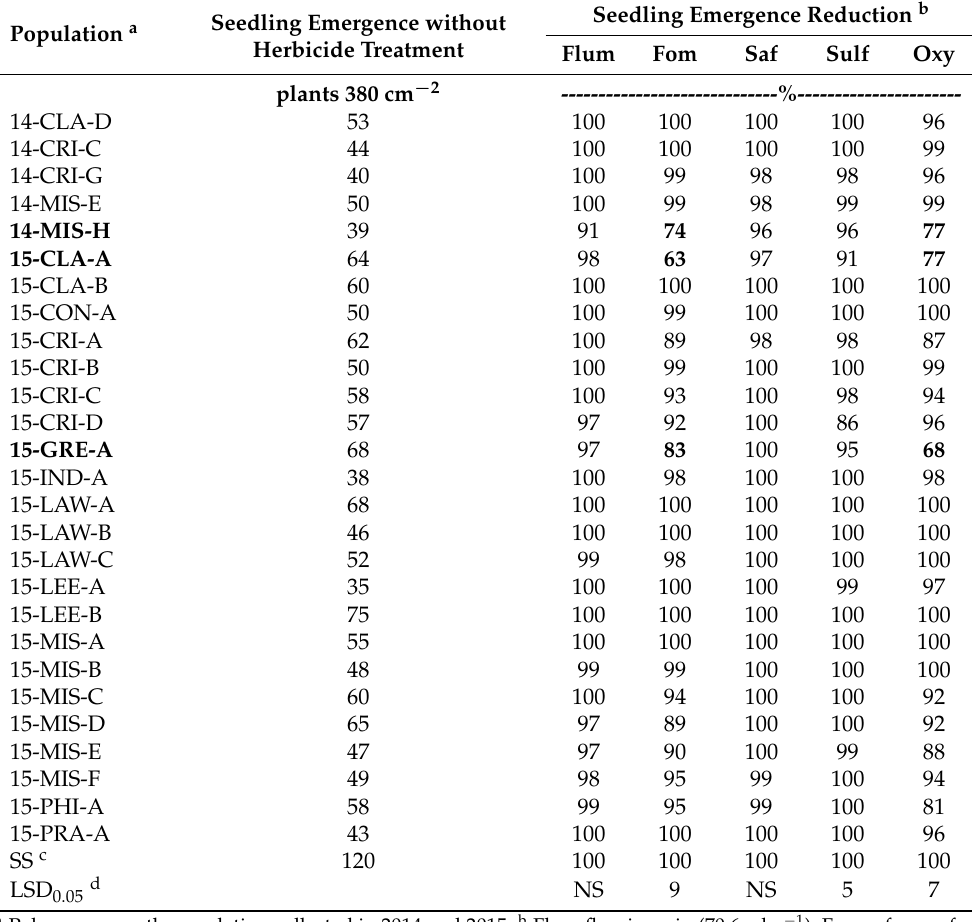
Table 1. Seedling emergence reduction in Palmer amaranth populations treated with various soil- applied herbicides at the recommended dose. Seedling Emergence without Population a Herbicide